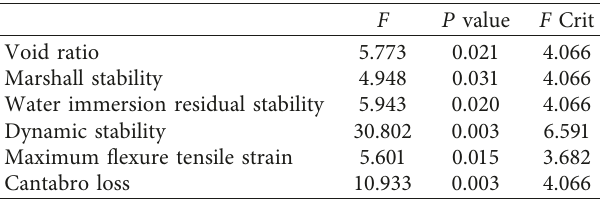
Table 4: Results of variance analysis.